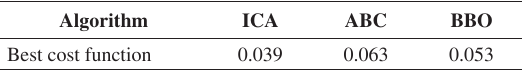
Table 3. Comparison of the abilities of the ICA, ABC and BBO algorithms. Algorithm